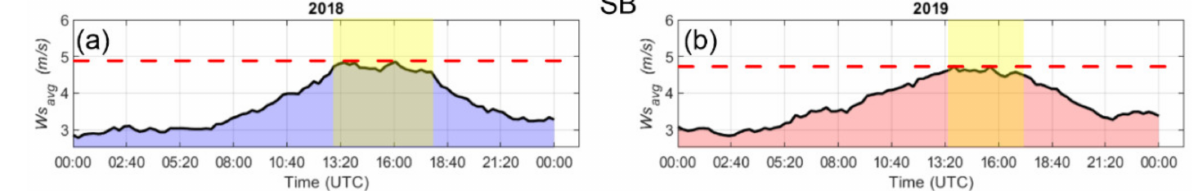
Figure 8. Time average of wind speed for all SB days during 2018 ( a ); 2019 ( b ).